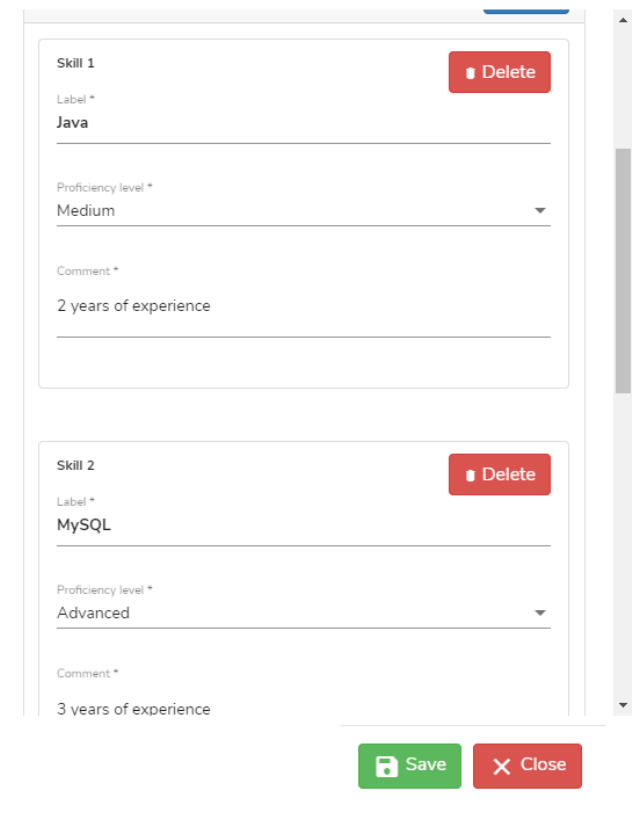
Figure 3. CV uploaded by learner.